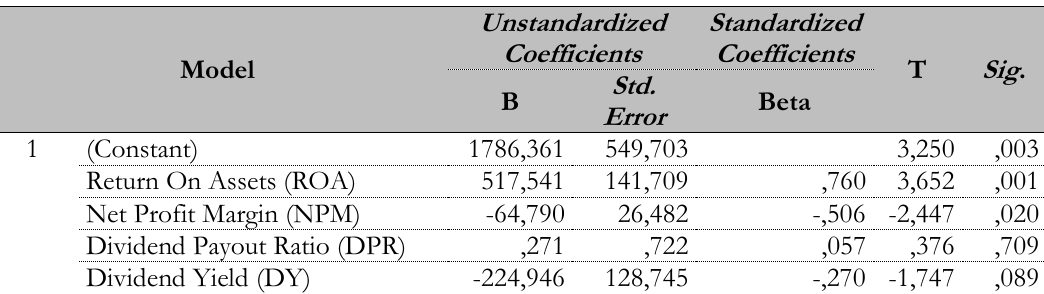
Table 1. Results of Multiple Linear